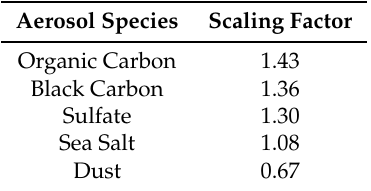
Table 3. Global 550 nm AOD Scaling Factors.